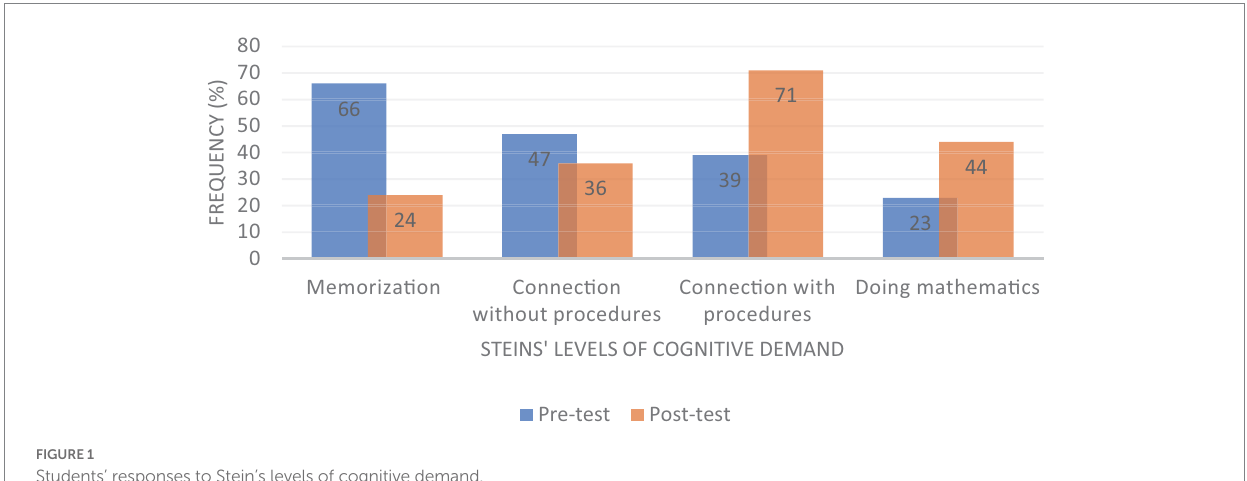
FIGURE 1 Students’ responses to Stein’s levels of cognitive